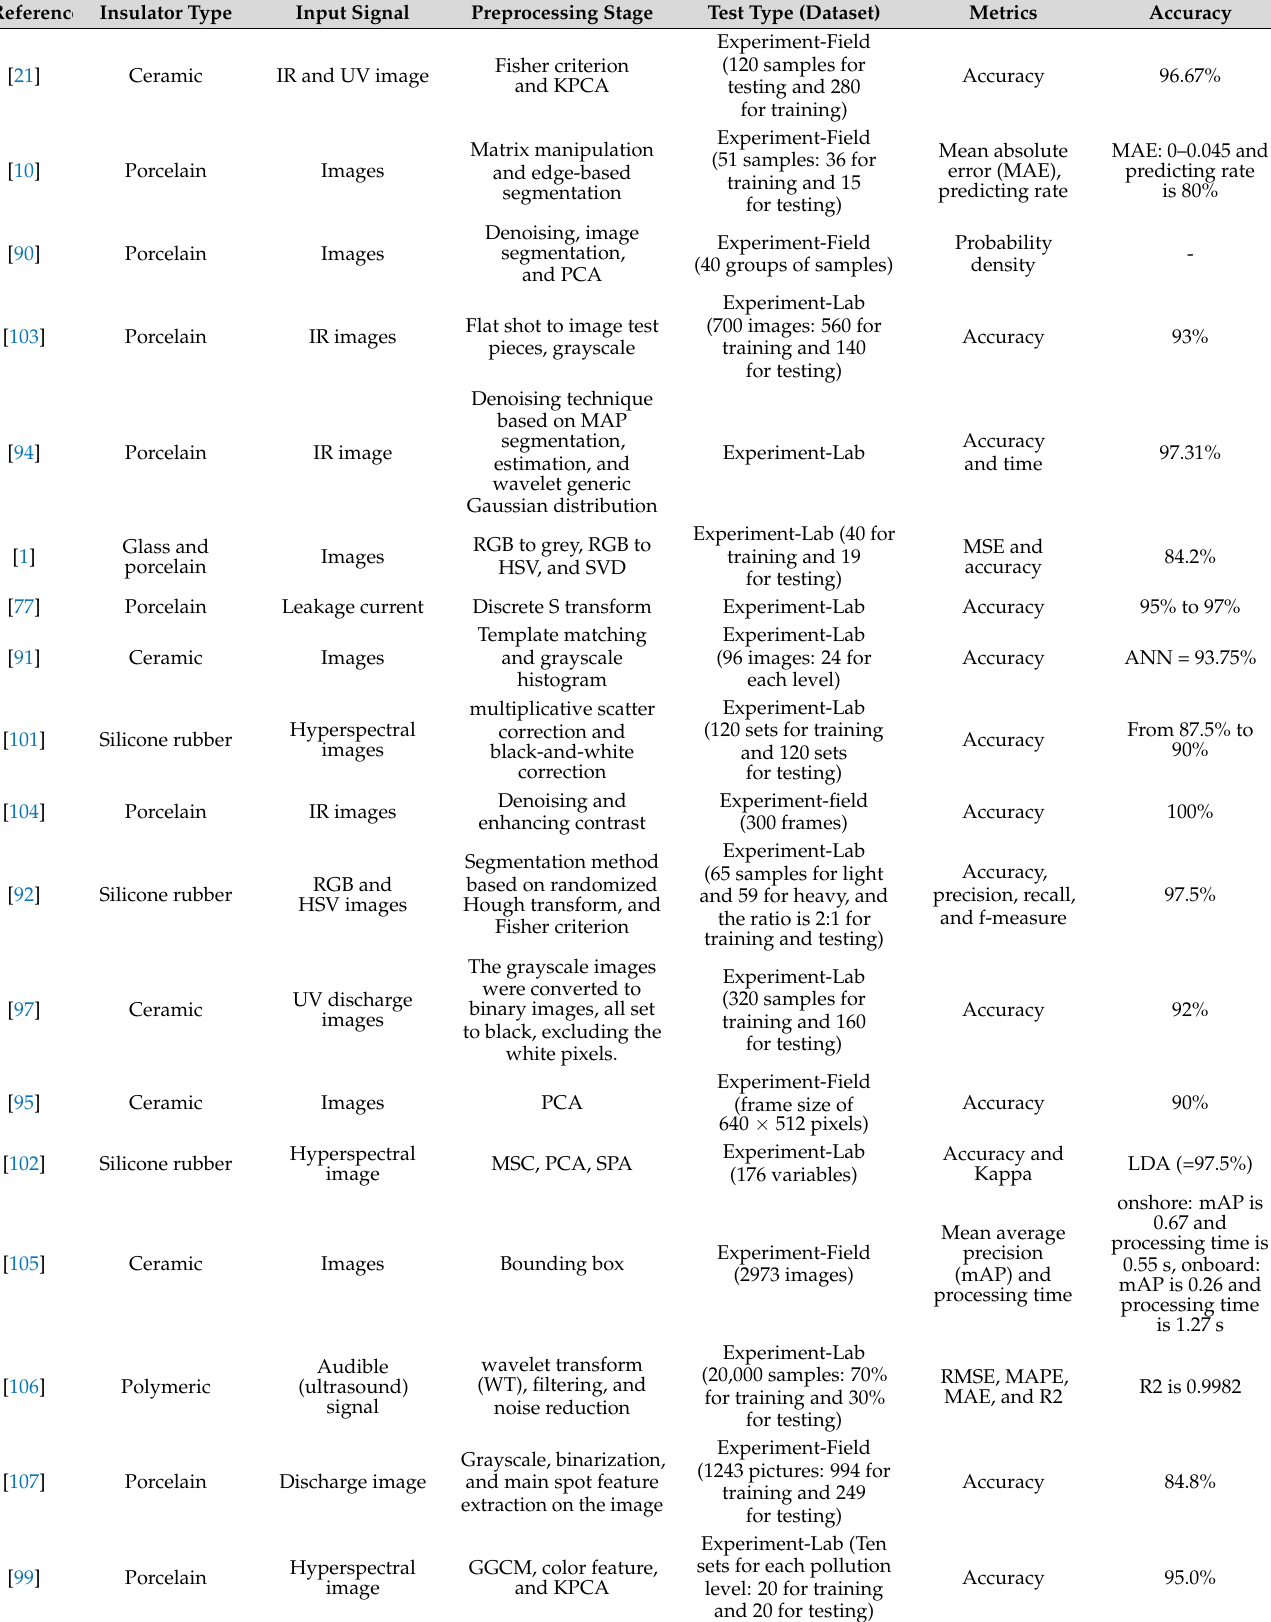
Table 8. The accuracy of using different types of images in detecting contamination